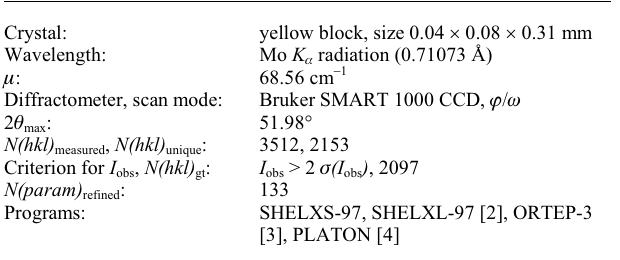
Table 1. Data collection and handling.